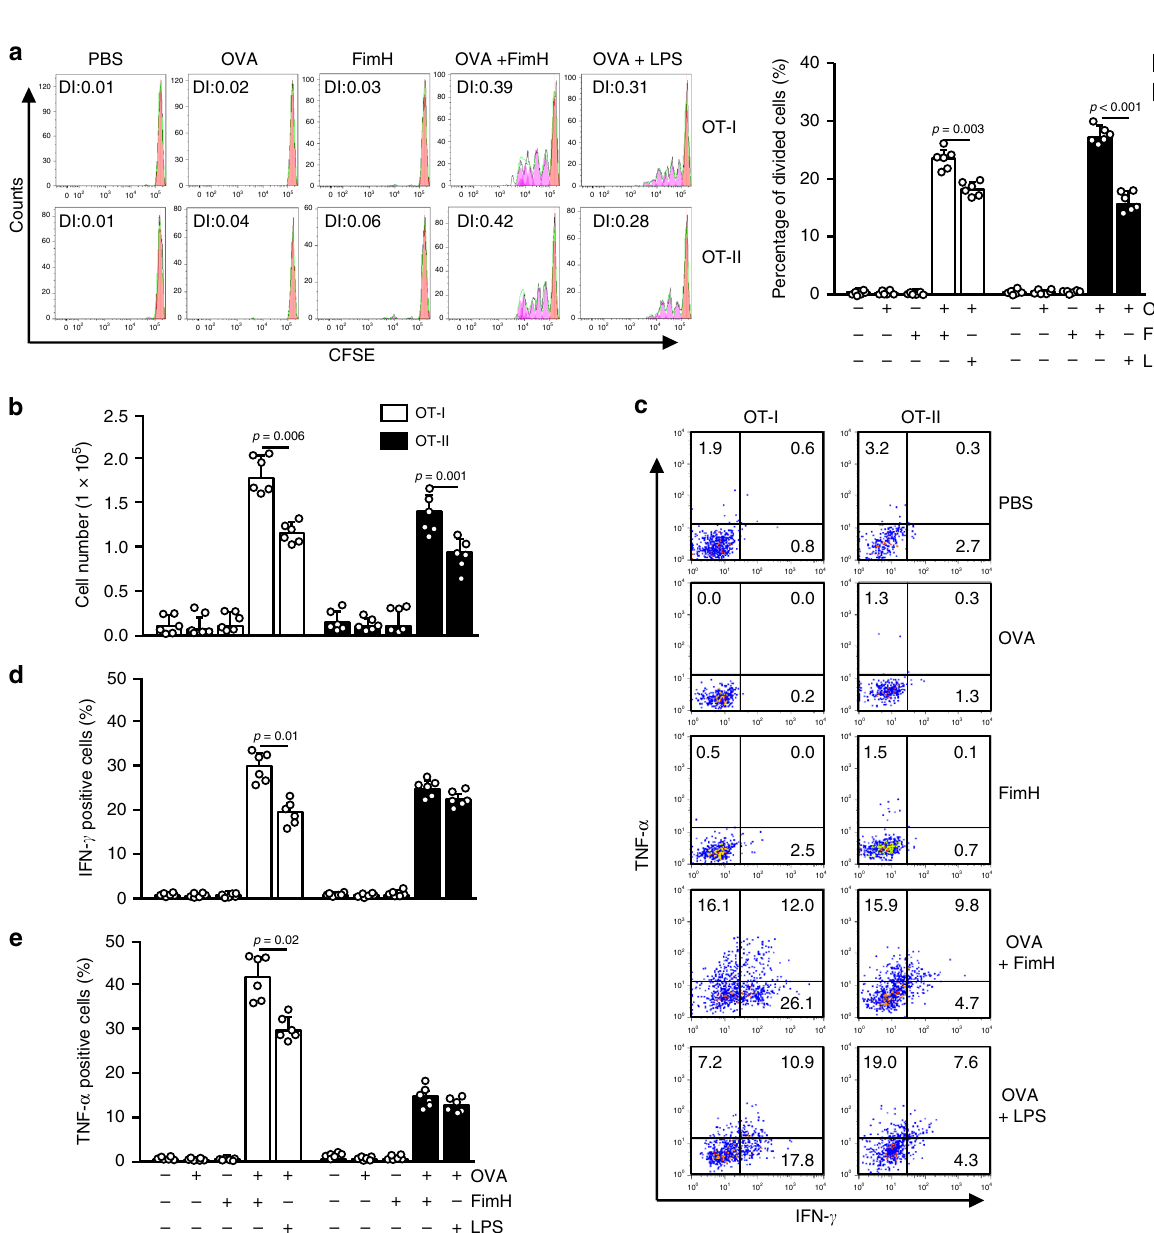
Fig. 3 FimH enhances OVA-speci fi c T-cell immunity in mice in vivo. C57BL/6 mice were injected s.c . with 1 × 10 6 B16-OVA cells. Ten days after tumor- cell injection, CFSE-labeled OT-I and OT-II cells were transferred into the mice and subsequently treated with 2.5 mg per kg of OVA, 2.5 mg per kg of FimH, or a combination of OVA and FimH for 24 h. Tumor-draining lymph nodes (drLN) and tumors were harvested 3 days after treatment. a The proliferation of OT-I and OT-II T cells in the tumor-drLN of the CD45.1 congenic mice (left panel) and the mean percentages of the proliferating cells are shown (right panel). Division index (DI) was calculated by proliferation assay tool in fl owjo software. ( n = 6 mice, one-way ANOVA, mean ± SEM). b The absolute numbers of the tumor-in fi ltrating OT-I and OT-II cells. ( n = 6 mice, one-way ANOVA, mean ± SEM). c The percentages of IFN- γ - and TNF- α -producing cells within the tumor-in fi ltrated OT-I and OT-II cells. d The mean percentages of IFN- γ - and e TNF- α -producing OT-I and OT-II cells are shown. ( n = 6 mice, one-way ANOVA, mean ±